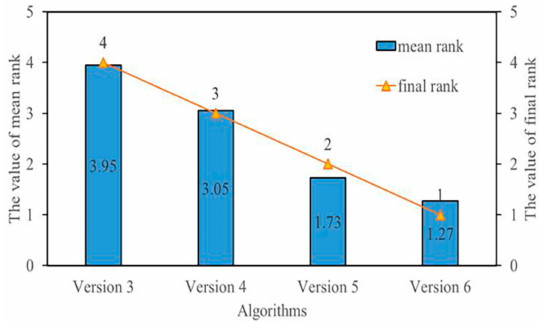
Figure 4. The ranks of the five participating algorithms.